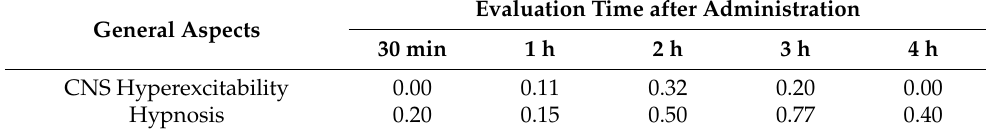
Table 2. Mean of the numerical parameter used for evaluating the toxicological, motor, and consciousness-related effects of a single-dose oral administration of EPPR. The toxicity scale ranges from “0” to